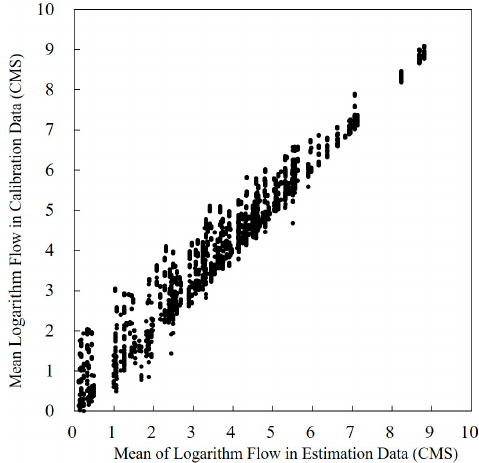
Figure 2. Correlation between mean of flows in calibration and estimation data.